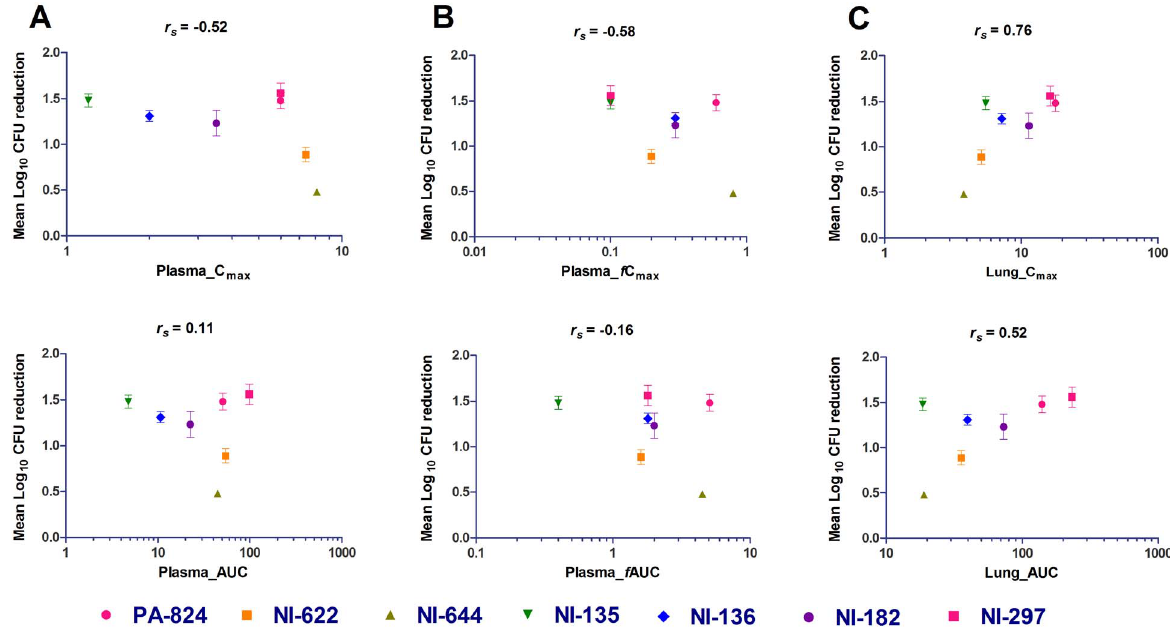
Figure 2. Correlation of PK parameters (C max , AUC) with invivo efficacy in mice for bicyclic 4-nitroimidazole analogs in total plasma concentration (A), free plasma concentration (B) and total lung concentration (C). Each data point represents D mean log lung CFU reduction compared to untreated controls (mean value 6 SEM from 5 animals). r s is the Spearman’s rank correlations coefficient. doi:10.1371/journal.pone.0105222.g002 PLOS ONE |